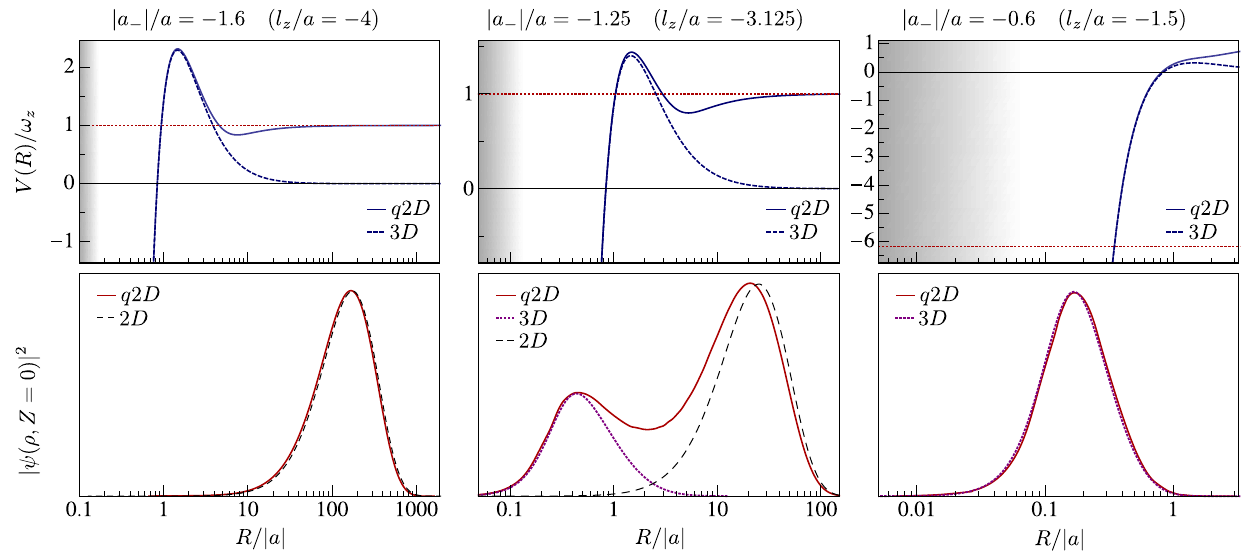
FIG. 4. Three-body potentials and corresponding wave functions of the deepest trimer. The upper panels show the q2D adiabatic ¼ 0 . 4 . For reference, we also show the 3D potential. hyperspherical potential V ð R Þ for three different interactions j a − j =a , assuming C z . The shaded area corresponds to the regime of short-distance physics where R is less Note that the potentials match in the region R < l z than the van der Waals range which is of the order of 1 = Λ . The resulting energies of the ground-state trimer are shown as dashed horizontal lines. In the lower panels, the in-plane q2D probability densities j ψ ð ρ ; Z ¼ 0 Þj 2 are compared with the probability densities expected in purely 2D and 3D. This illustrates three qualitatively different interaction regimes: (left) for weak interactions, the trimer resides in the long-range attractive tail of the potential and matches the 2D result; (center) for intermediate interactions, a ∼ a − , the trimer configuration is a superposition of trimers of 2D and 3D character. Here, as there is no Efimov trimer at this scattering length in 3D, the 3D probability density is instead evaluated at j a − j =a slightly larger than − 1 . Right: For stronger interactions j a − j =a > − 1 , the trimer wave function resides mainly in the regime R < j a j and closely resembles the 3D wave